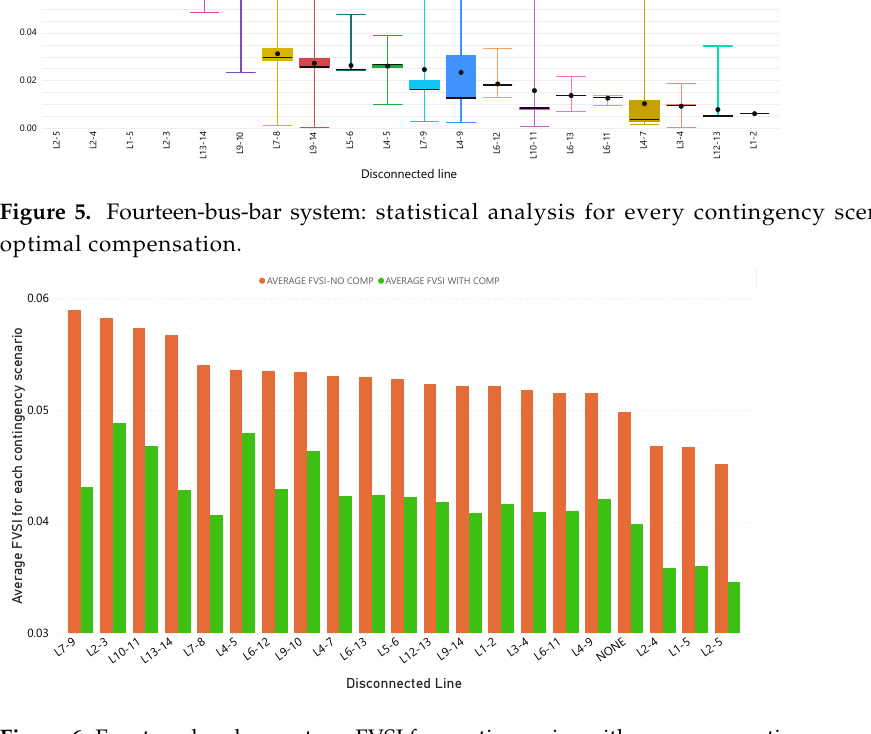
Figure 6. Fourteen-bus-bar system: FVSI for contingencies with no compensation vs. contingencies with optimal